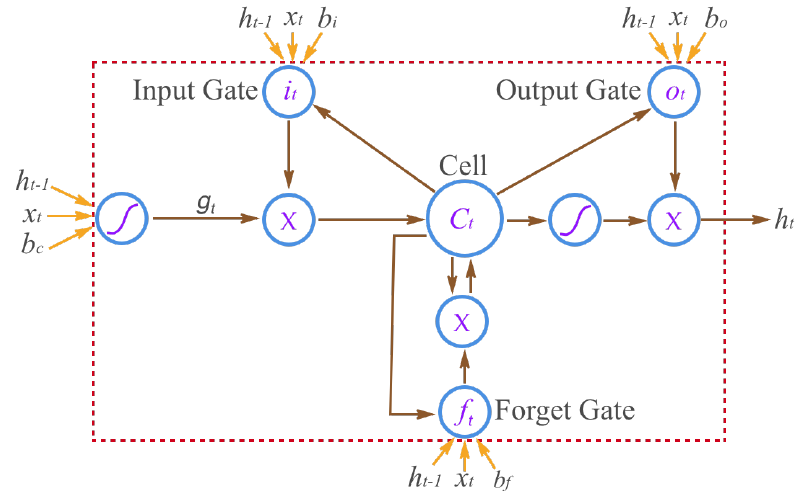
Figure 4. The basic Long Short-Term Memory (LSTM)